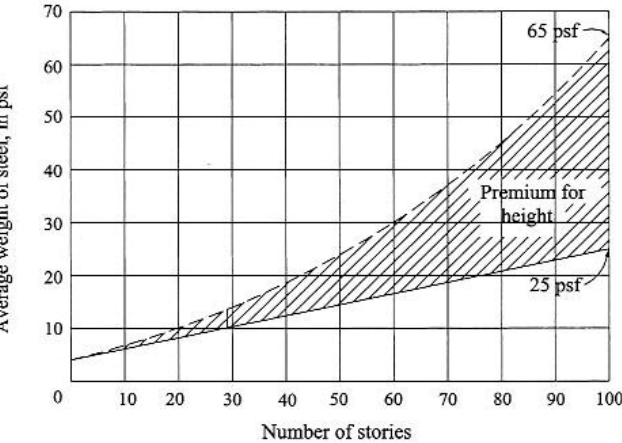
Figure 1. Premium for height by Fazlur Khan [4].